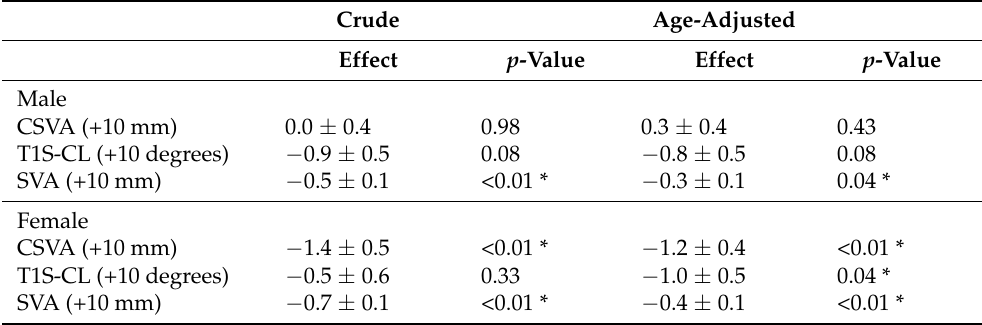
Table 4. Effects of cervical alignment parameters on SF-8 TM physical component summary scores.